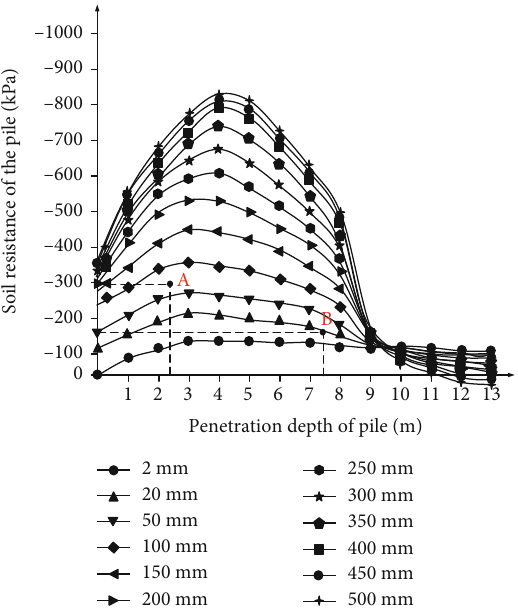
Figure 10: Soil resistance in front of pile is distributed along pile